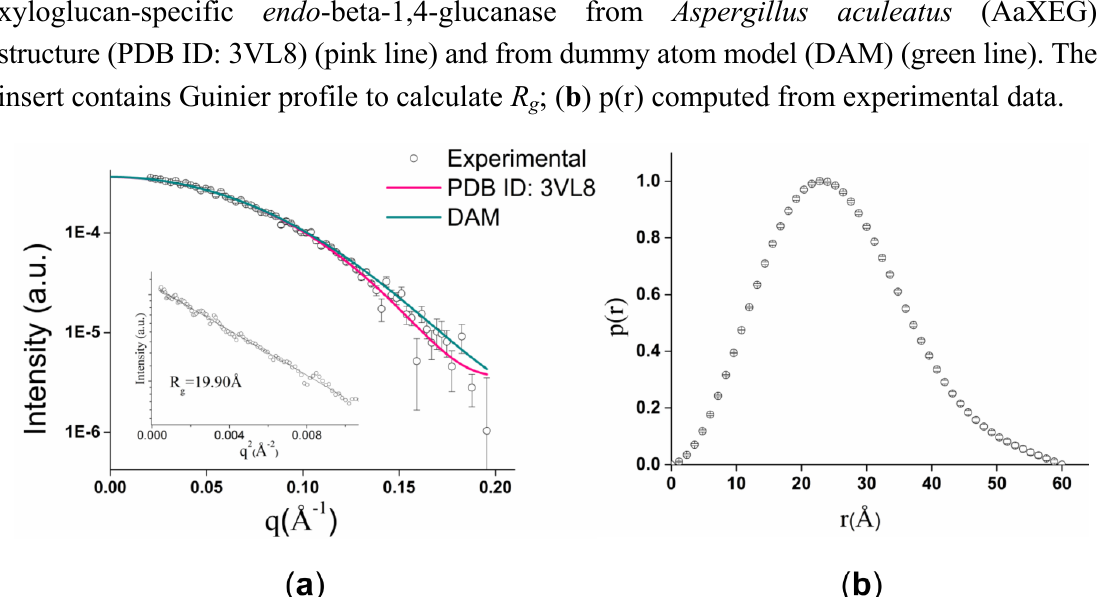
Figure 2. GtCel12A analysis by small angle X-ray scattering (SAXS). ( a ) Experimental